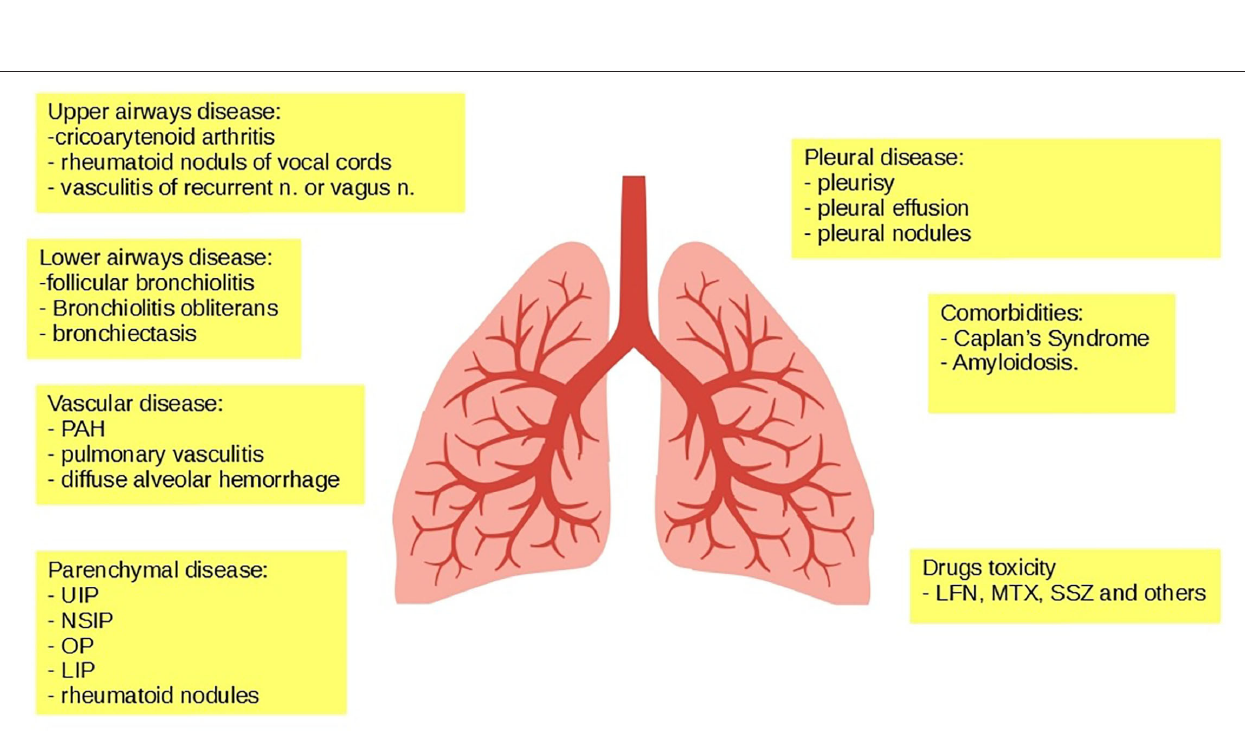
FIGURE 1 | Lungs as a site for the initiation of rheumatoid arthritis (RA).